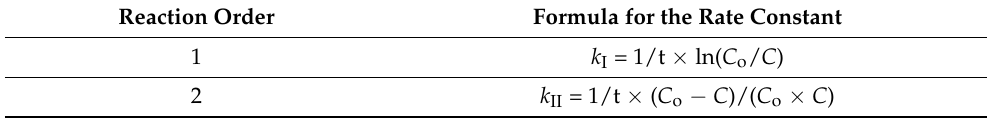
Table 2. Rate constant equations ( C —concentrations of substrates; C o— initial; C —current). Reaction